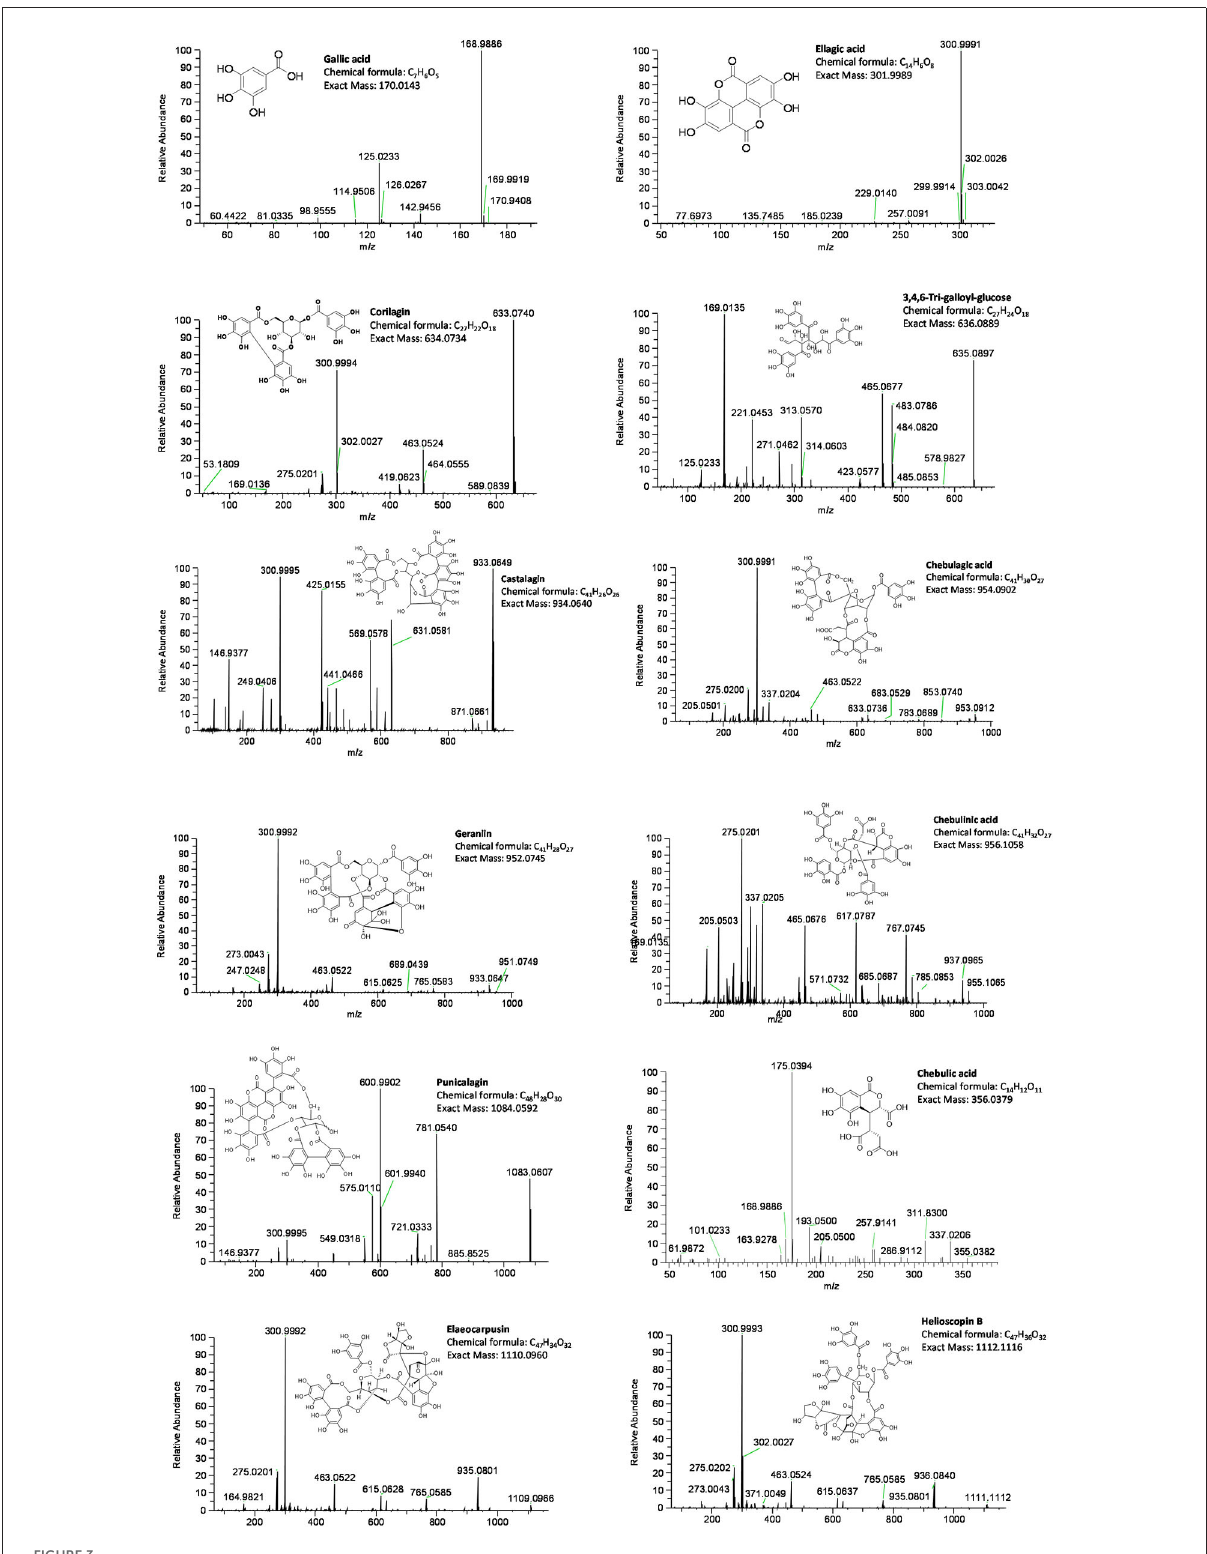
FIGURE3 Molecular structures and mass features of the study